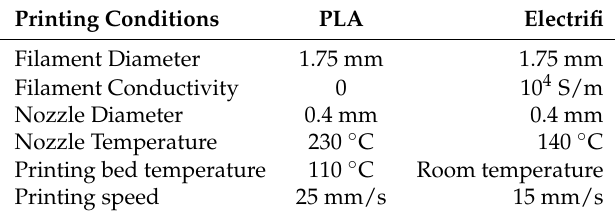
Table 1. Printing conditions for PLA and Electricfy